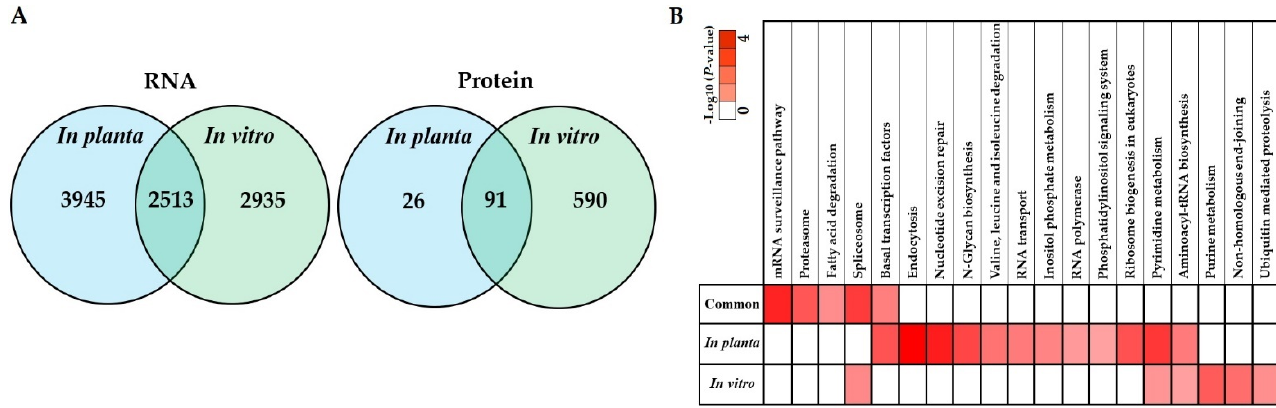
Figure 6. Venn diagrams depicting the overlap of identified proteins common between or independent in the in vitro and in planta analysis of S. subterranea transcriptome and proteome ( A ). Pathway analysis of identified proteins common between or independent in the in vitro and in planta analysis of S. subterranea transcriptome ( B ).